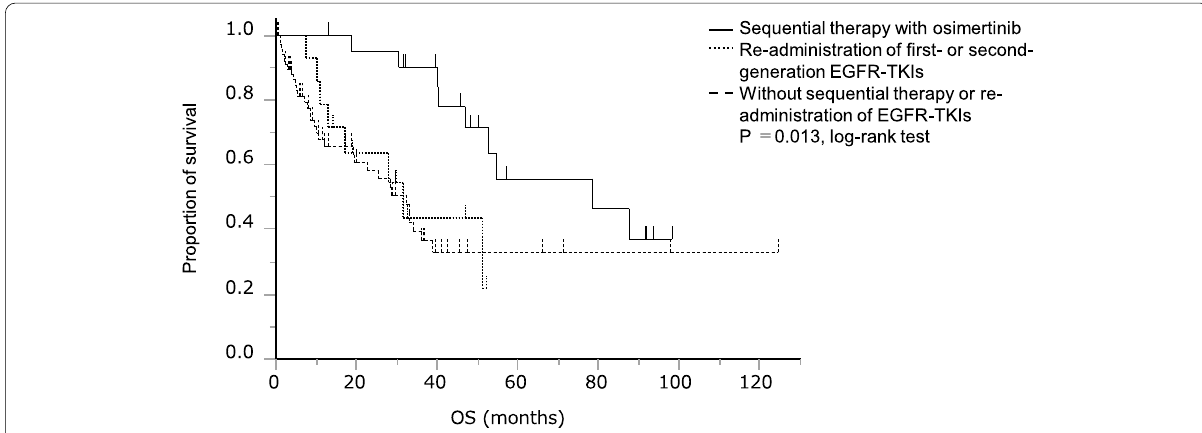
Fig. 1 Kaplan-Meier curve for OS in patients who received sequential therapy with osimertinib, who received re-administration of the first-/second-generation EGFR-TKIs, and who received neither of the above. Solid line: the patient group that received sequential therapy with osimertinib; dotted line: the patient group that received re-administration of first-/second-generation EGFR-TKIs; dashed line: patients who received neither sequential therapy with osimertinib nor re-administration of first-/second-generation EGFR-TKIs